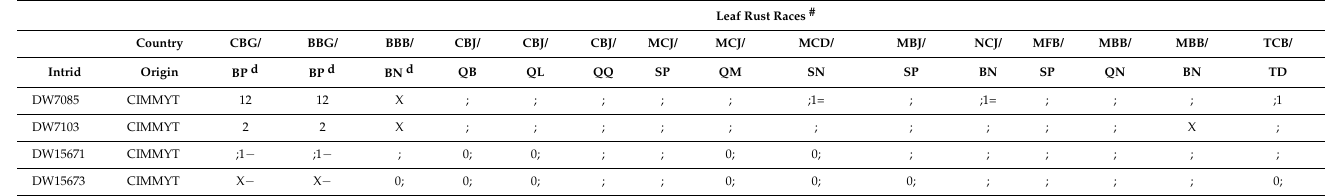
Table 2. Infection types of tetraploid accessions in response to 15 leaf rust races at seedling stage in the